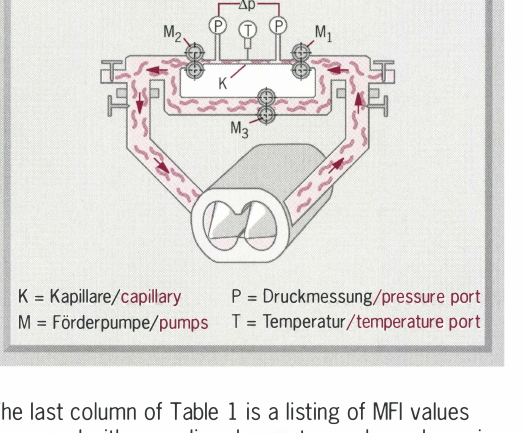
On-line rheometer with overlapping fluid stream to